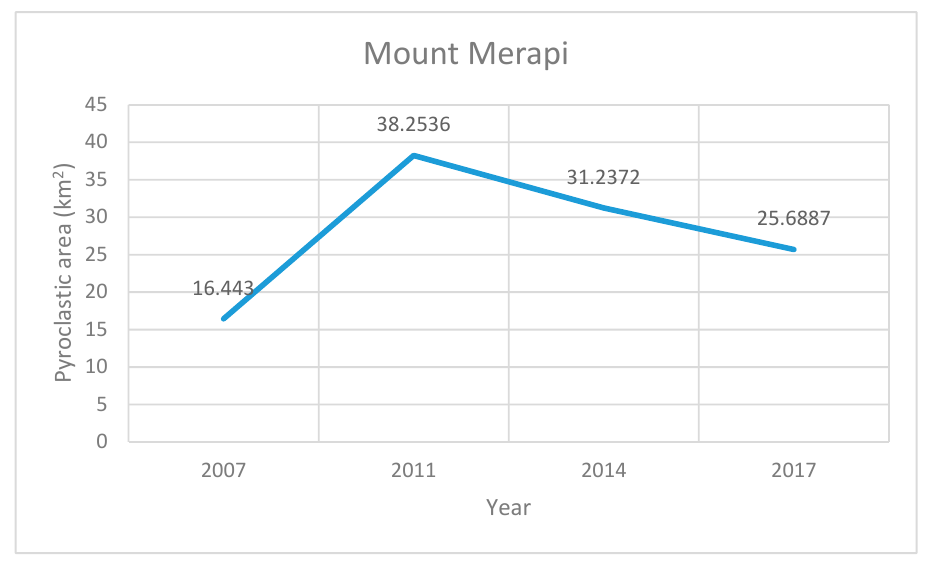
Figure 8. Time series of pyroclastic flow deposit for Mount Merapi. Table 2. Time series of pyroclastic flow deposit.